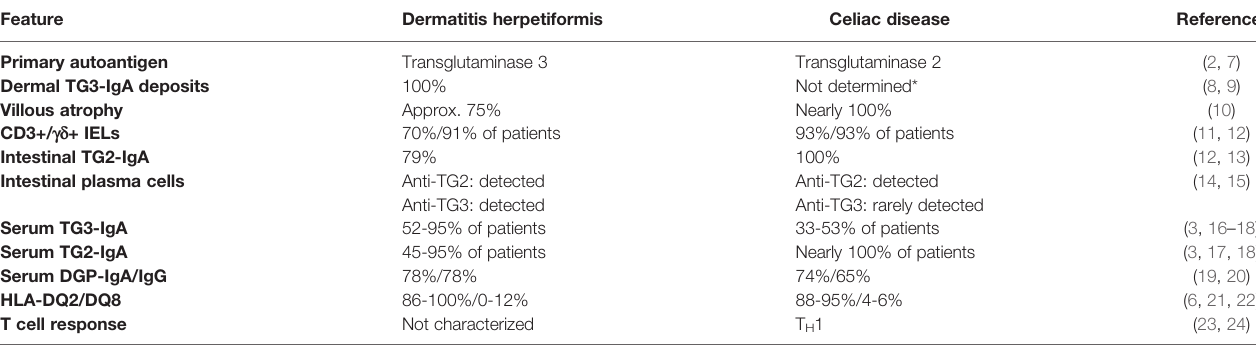
TABLE 1 | Comparison of the features of dermatitis herpetiformis and celiac disease. Feature Dermatitis